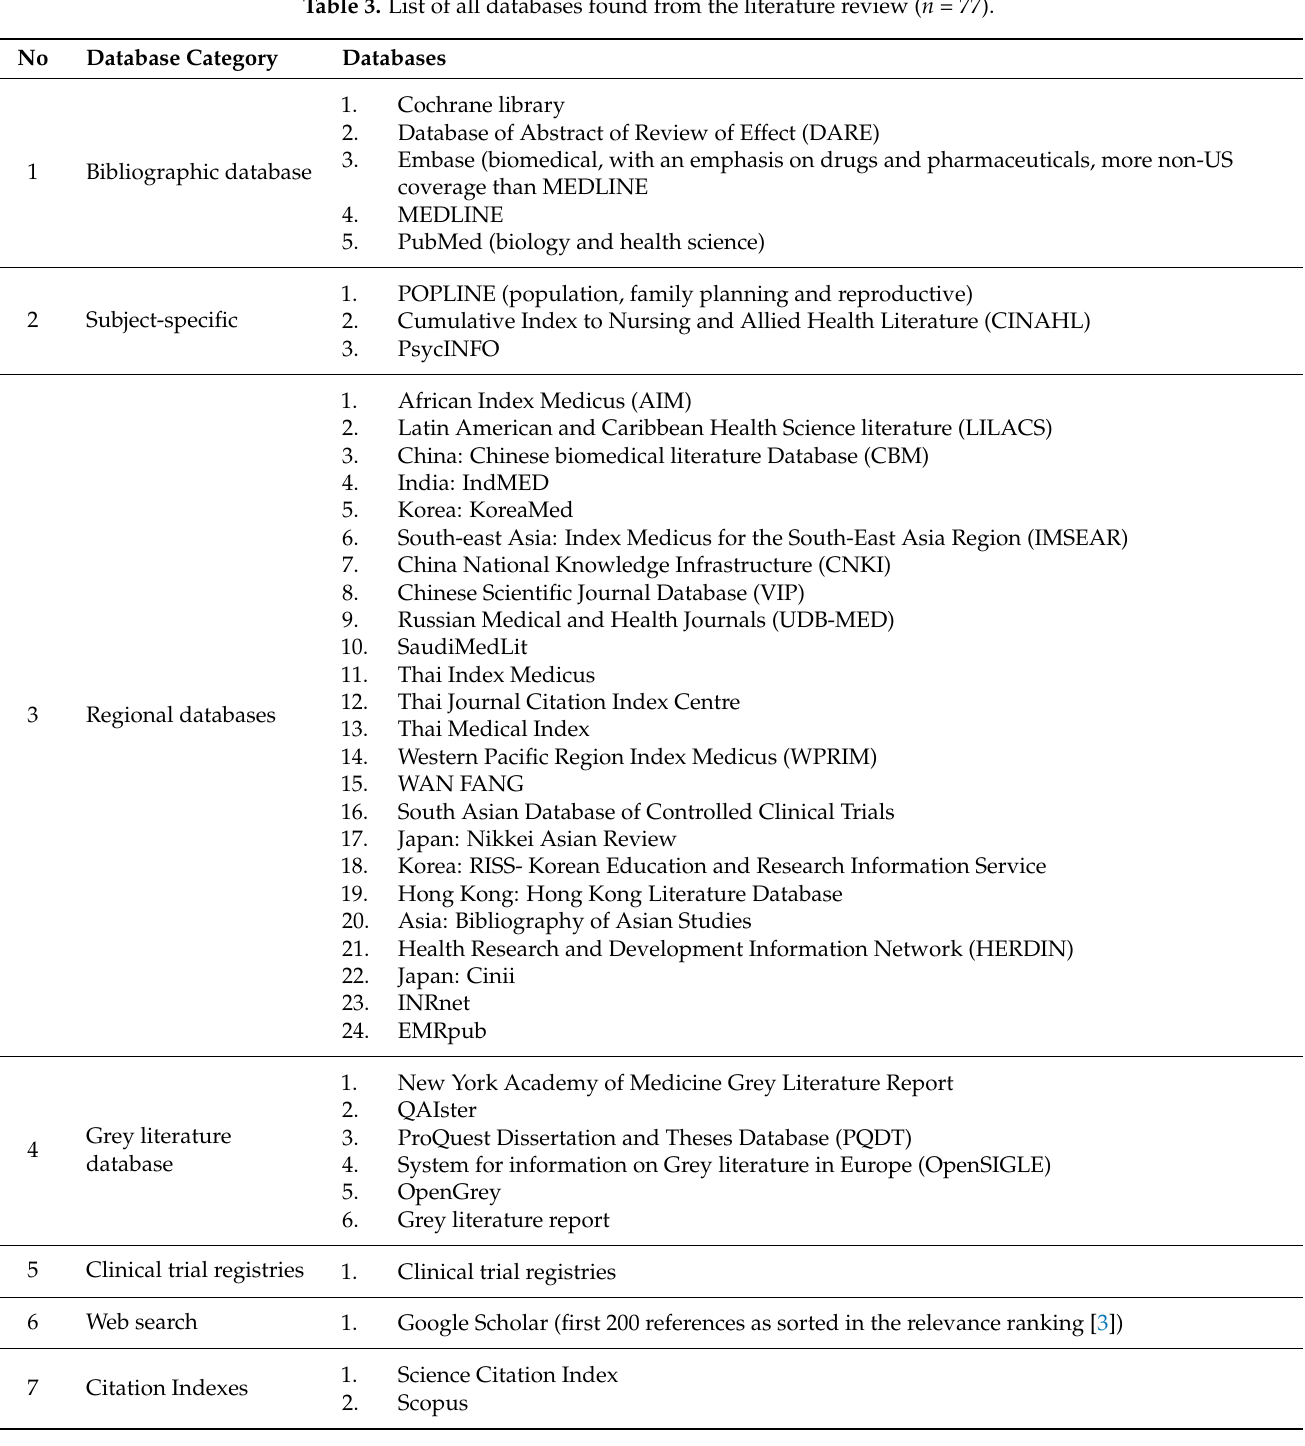
Table 3. List of all databases found from the literature review ( n =